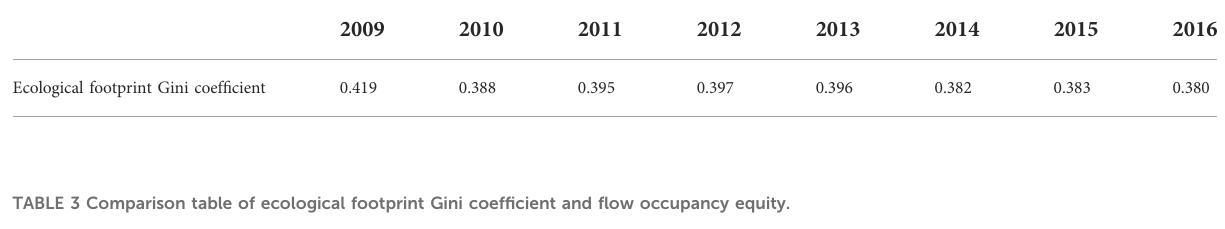
TABLE 3 Comparison table of ecological footprint Gini coef fi cient and fl ow occupancy equity. G ≤ 0 . Ecological footprint ) gini system ( G EF size